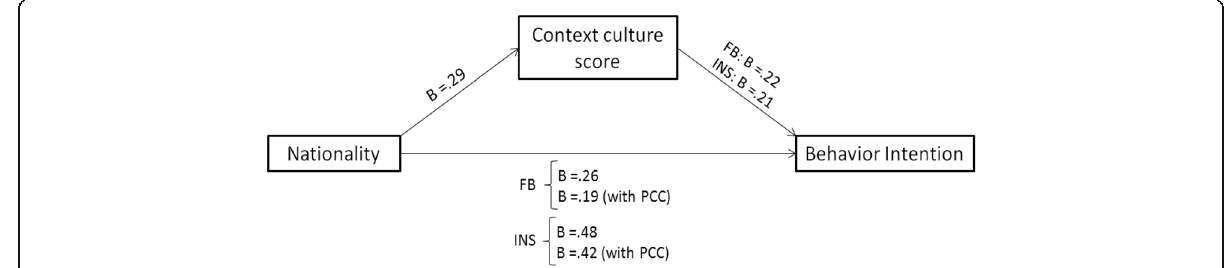
Fig. 2 Results of regression analyses in the theoretical model (source: Elaboration of the